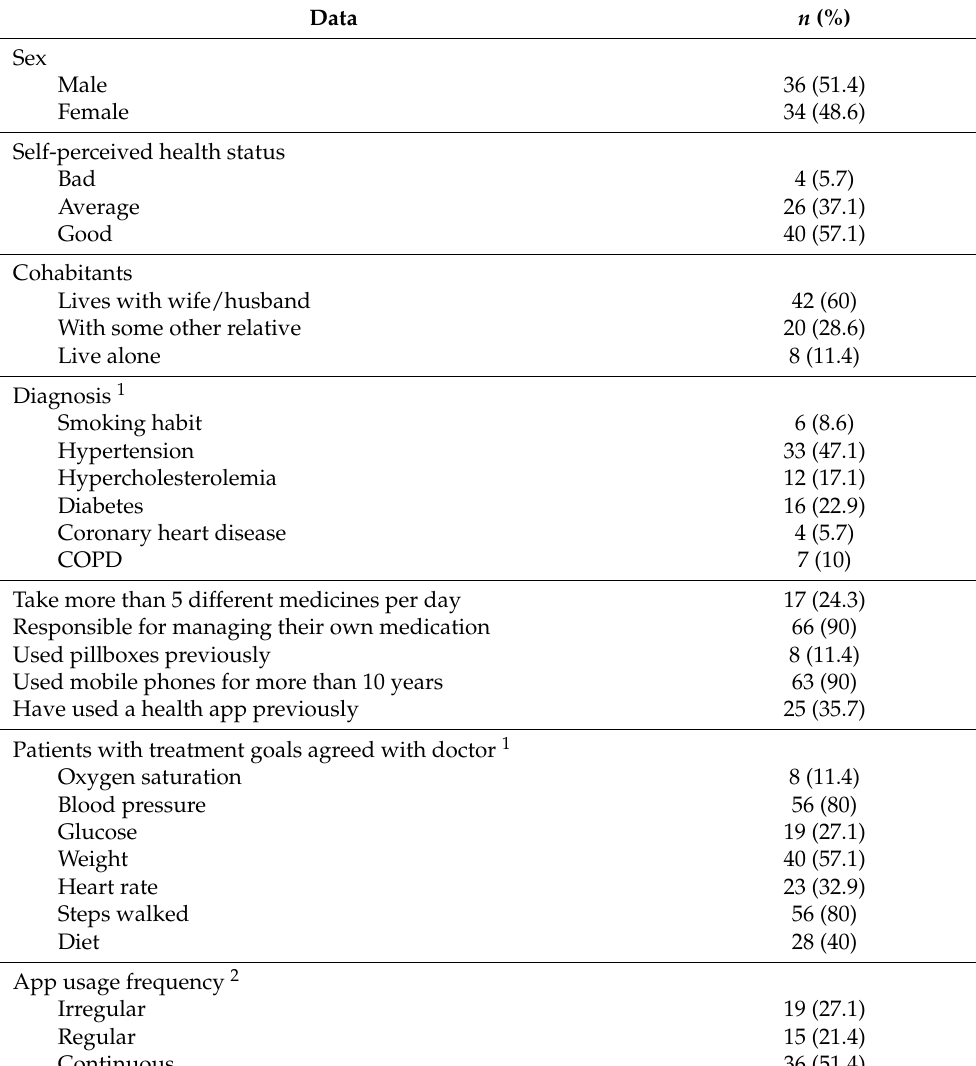
Table 1. Demographic data of participants.